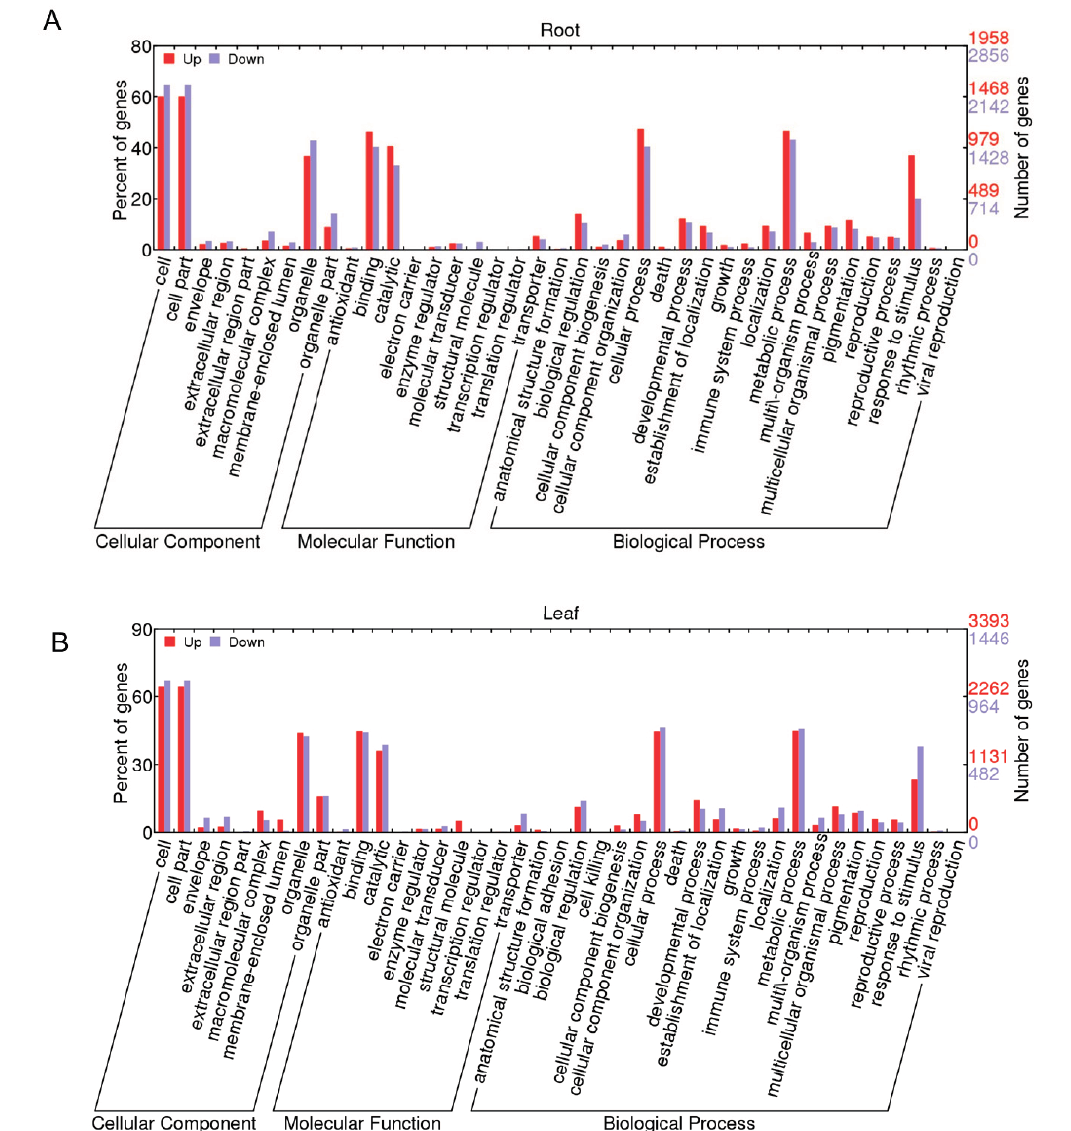
Figure 4. GO annotation of the differentially expressed genes in root ( A ) and leaf ( B ). The x -axis indicates the sub-categories, the left y -axis indicates the percentage of a sub-category of genes in that category, and the right y -axis indicates the number of unigenes in a